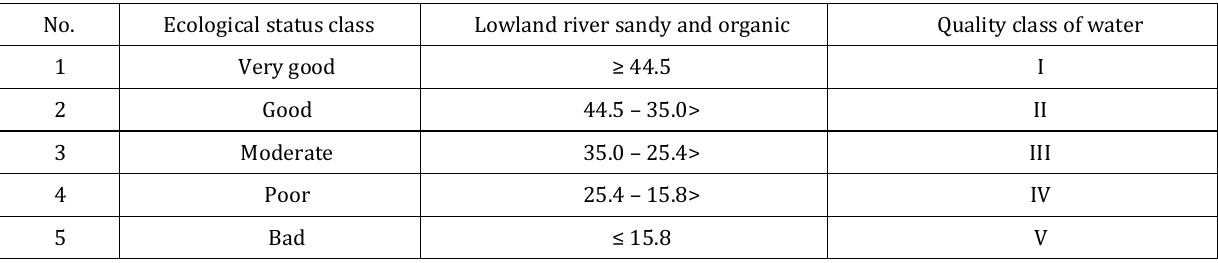
Table 3. Macrophyte Index for Rivers values for sandy type of river (after: Szoszkiewicz et al., 2010 No. Ecological status